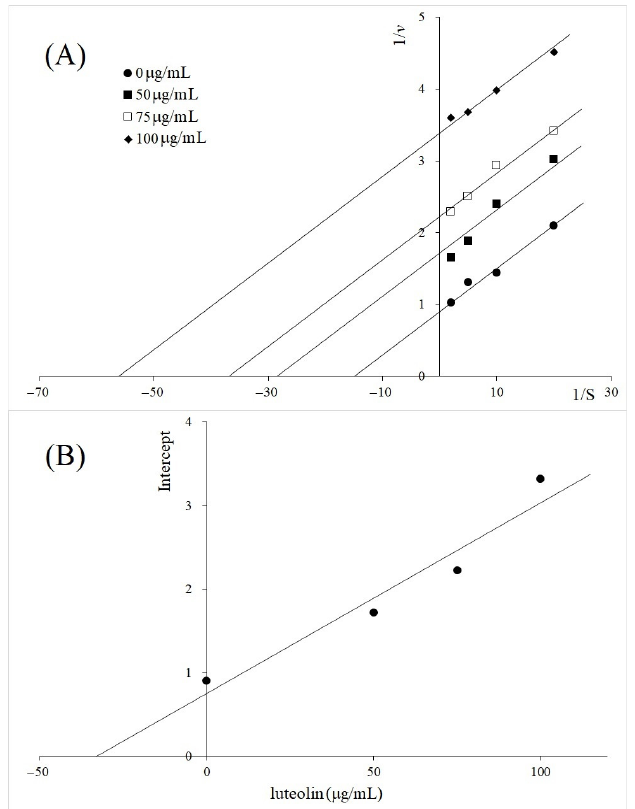
Figure 7. Tyrosinase inhibition kinetics of luteolin at the different concentrations of 50, 75 and 100 µ g/mL. ( A ) Lineweaver–Burk plot; ( B ) secondary plot for the inhibitor concentration and intercept (linear equation; y = 0.02295x + 0.7491, R 2 =